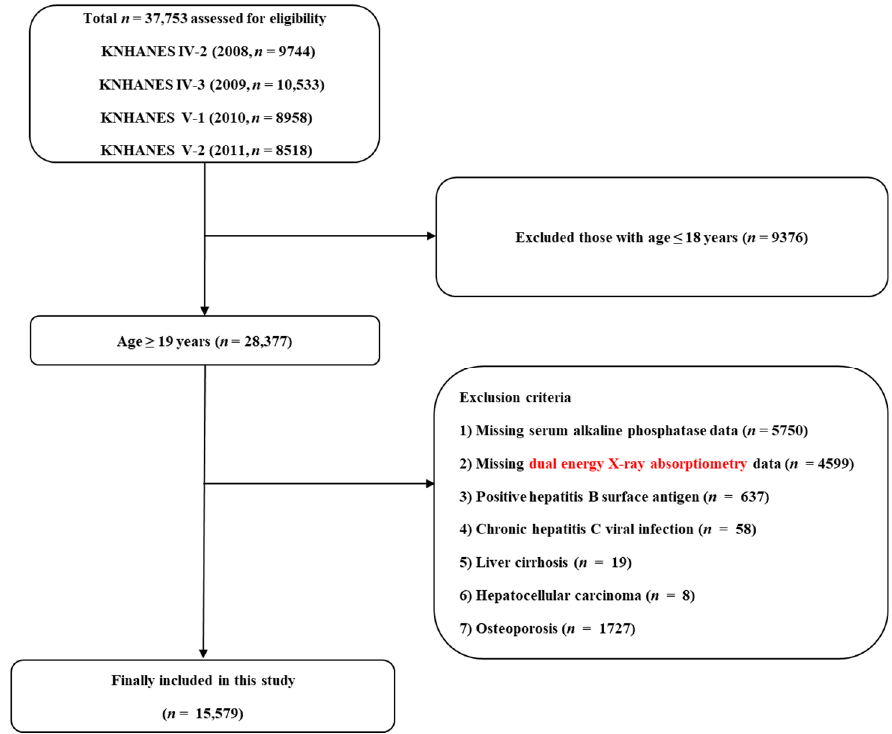
Figure 1. Flowchart of the study population